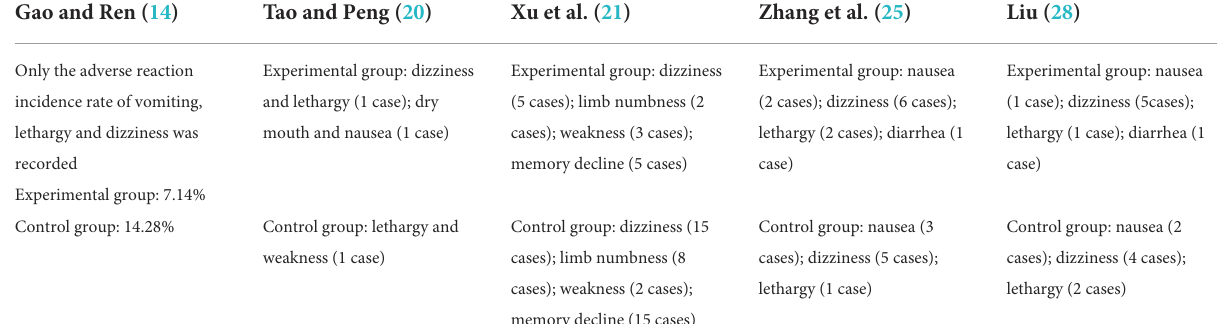
TABLE 2 Adverse reactions.